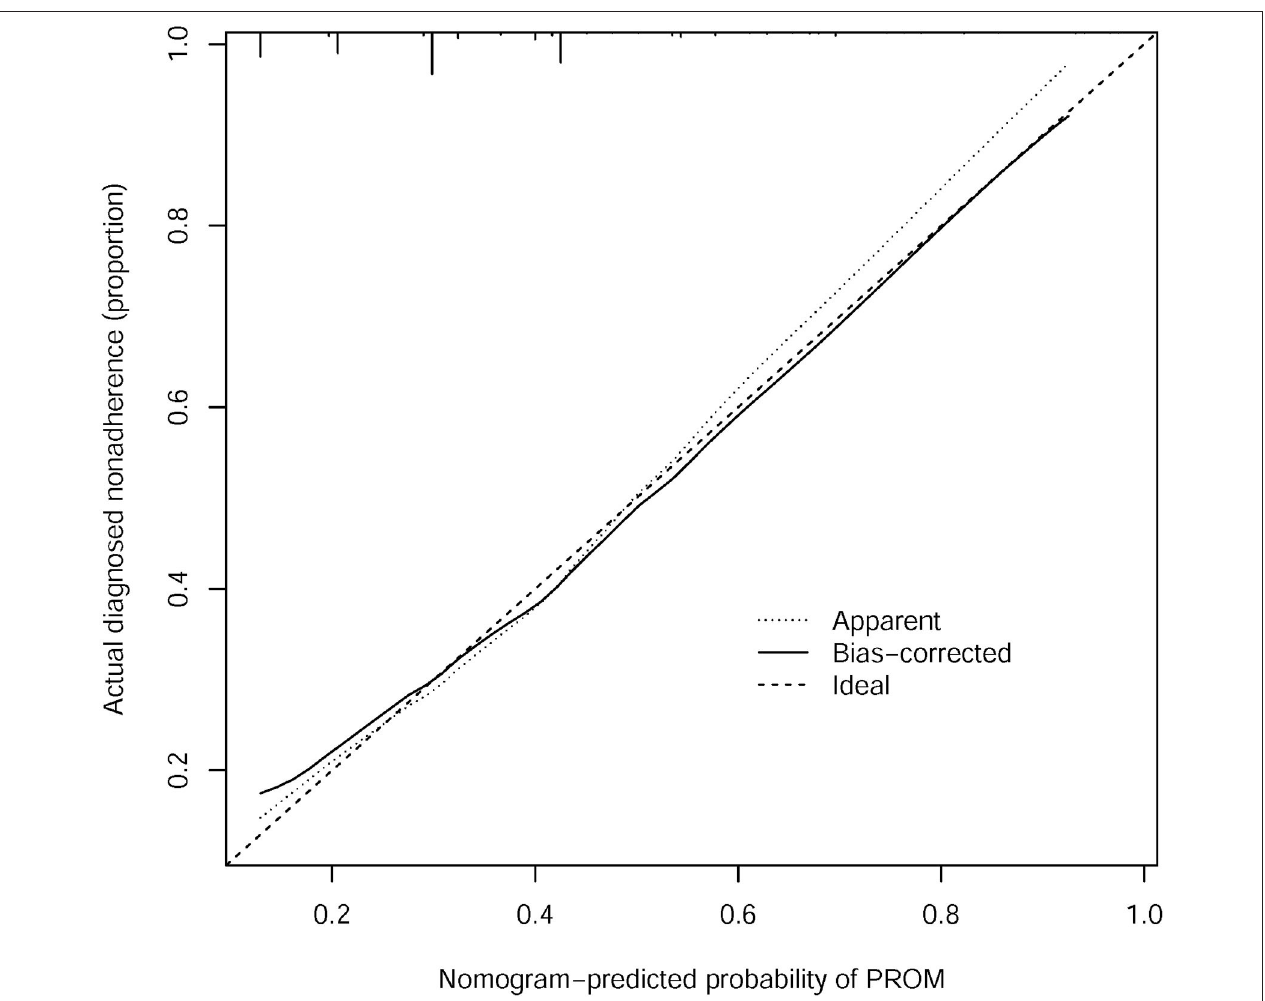
FIGURE 3 | Calibration curves of the PROM nomogram prediction in the